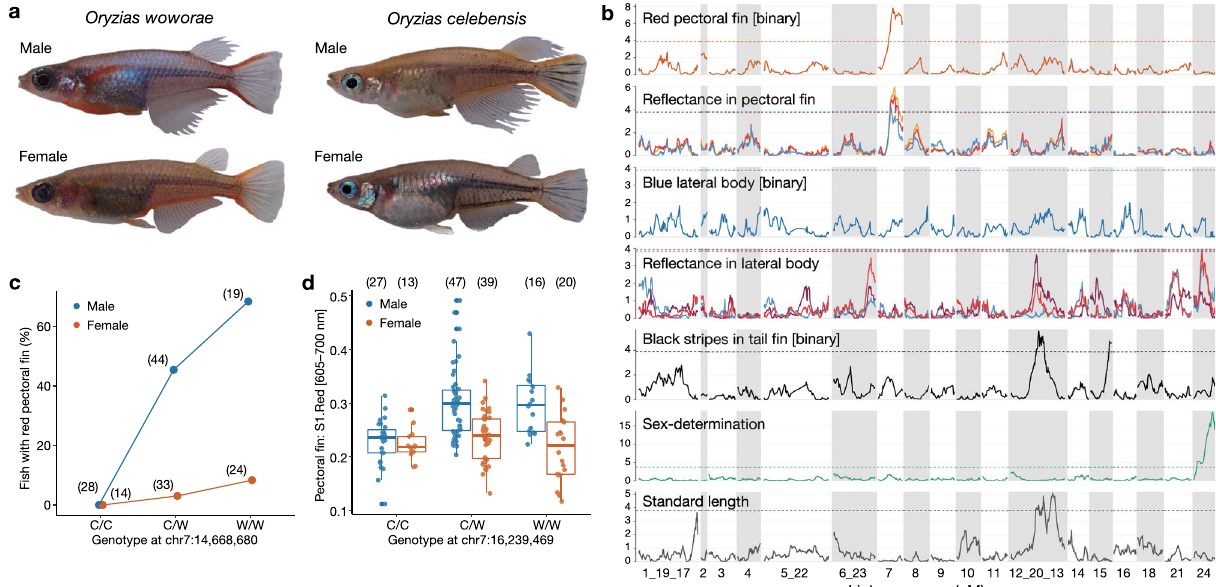
Fig. 2 Quantitative trait locus (QTL) mapping of body color divergence between O. woworae and O. celebensis . a Representative images of adult males and females of the parental species. b Logarithm of the odds (LOD) scores plotted against the chromosomal position on each linkage group. For re fl ectance values, the different colors indicate the relative contributions of a particular spectral range (red, 605 – 700 nm; yellow, 550 – 625 nm; blue, 400 – 510 nm; violet, 300 – 415 nm) to the total brightness. The dashed lines indicate the genome-wide signi fi cance thresholds determined by 1000 permutation tests ( α = 0.05). Signi fi cant QTLs are summarized in Supplementary Table 2. c , d Effect plots of the signi fi cant QTLs for the red pectoral fi ns. The X axis indicates the genotypes at each QTL: C/C, homozygous for the O. celebensis allele; W/W, homozygous for the O. woworae allele; C/W, heterozygote. Sample sizes are shown in the parenthesis. The Y axis indicates the percentage of fi sh with red pectoral fi ns ( c ) or the contribution of the red spectral range (605 – 700 nm) to the total brightness ( d ). d Each dot represents each individual. The blue and brown colors indicate males and females, respectively. In the box-plots, the center line indicates the median, box limits indicate the upper and lower quartiles, the whiskers indicate 1.5× interquartile range, and the points are outliers. Sample sizes are shown in the parentheses. Source data are provided as a Source Data fi